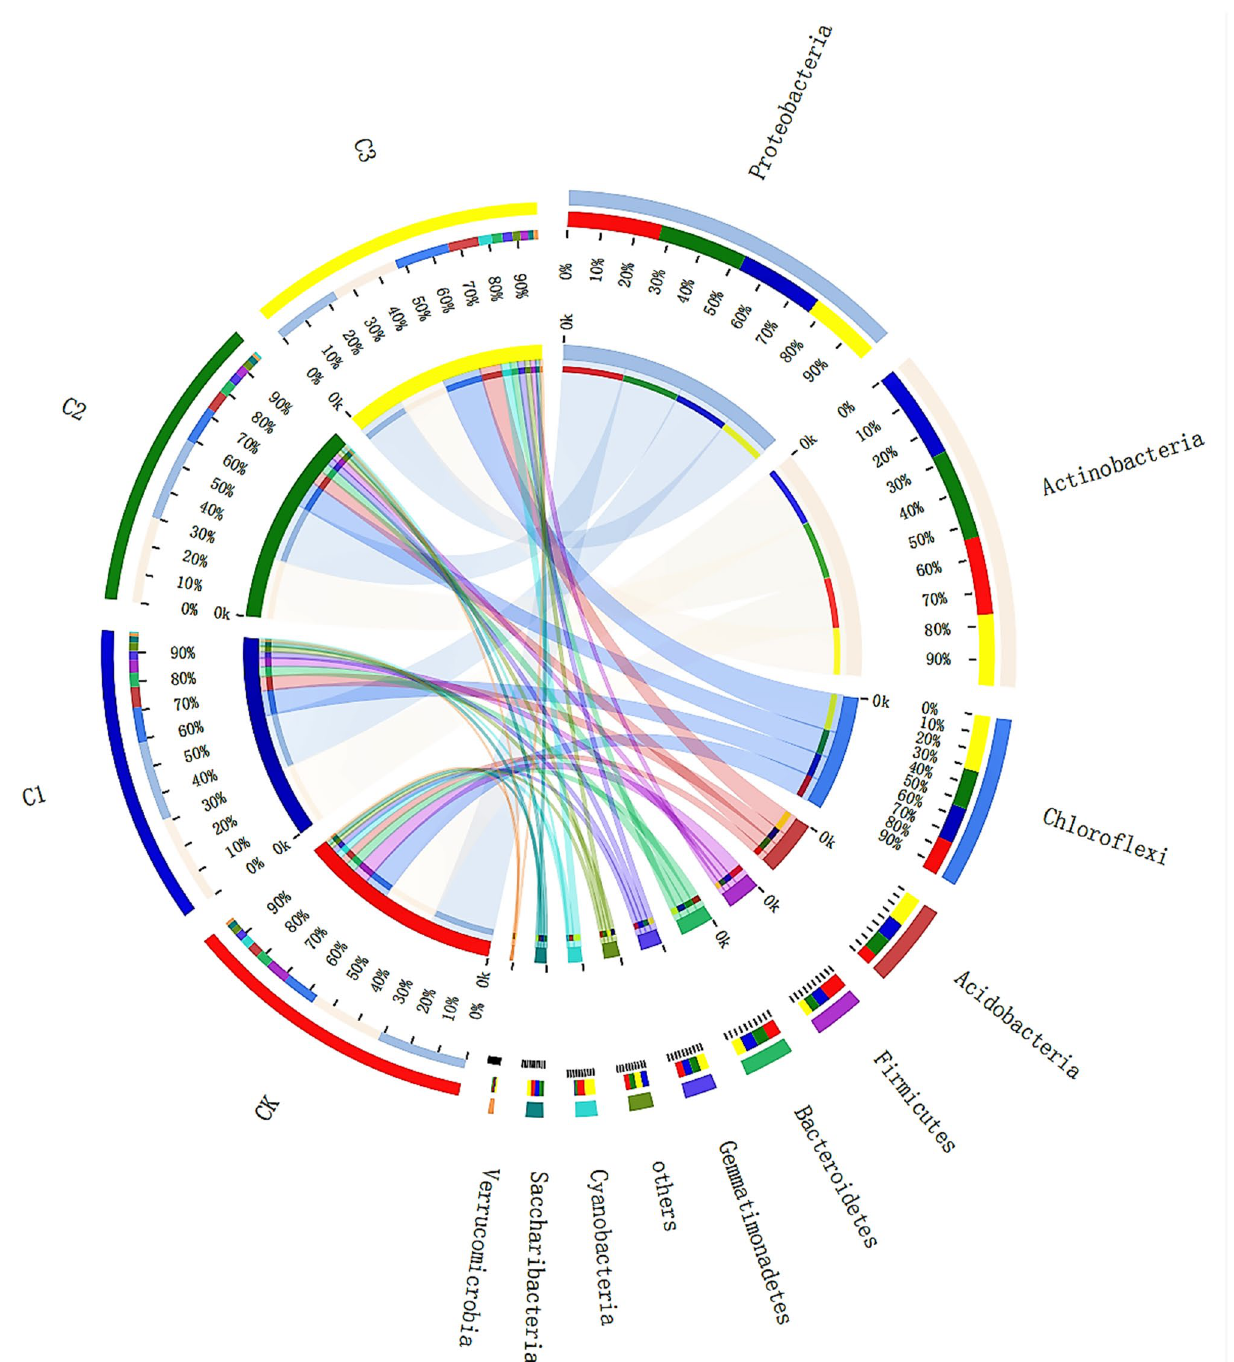
Figure 1. The abundance of soil bacteria on the Phylum level in the soft rock:sand compound soil. The image was created with the software Circos-0.67–7 (http://circo s.ca/). CK, the volume ratio of soft rock to sand is 0:1; C1, the volume ratio of soft rock to sand is 1:5; C2, the volume ratio of soft rock to sand is 1:2; C3, the volume ratio of soft rock to sand is